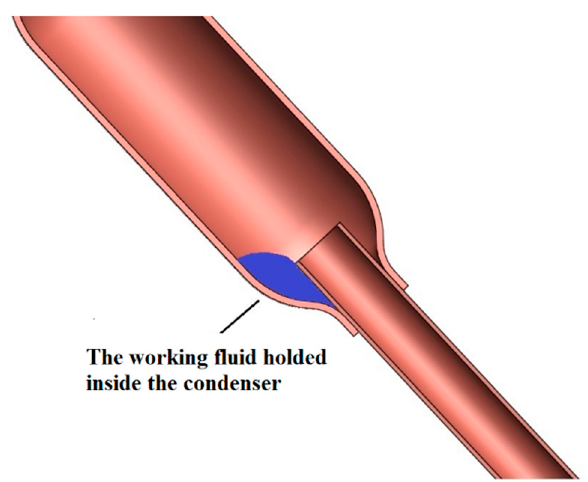
Figure 22. A condenser not properly seated on the adiabatic pipe.